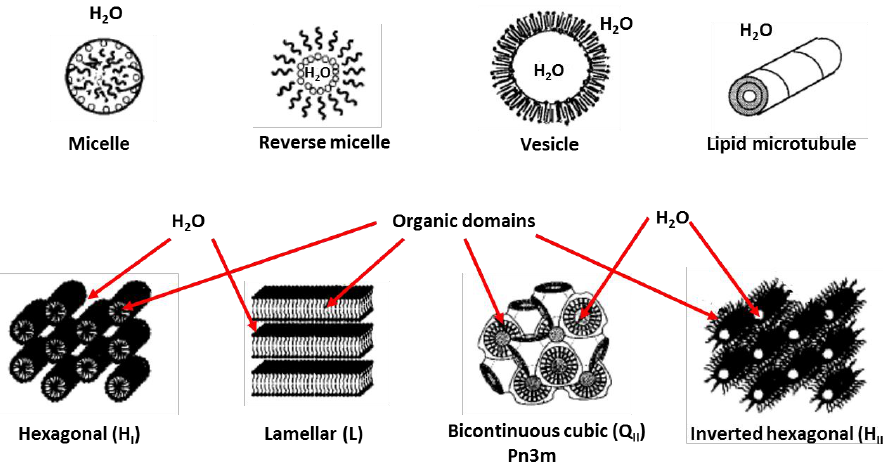
Figure 3. Different types of aggregates formed by surfactants with water [28] (Reprinted with permission from [28]. Copyright (2001) American Chemical Society).